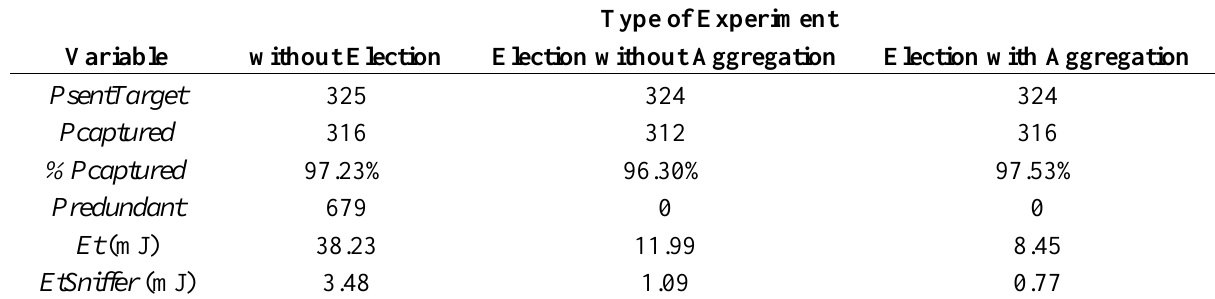
Table 6. Values of variables for a single round with 11